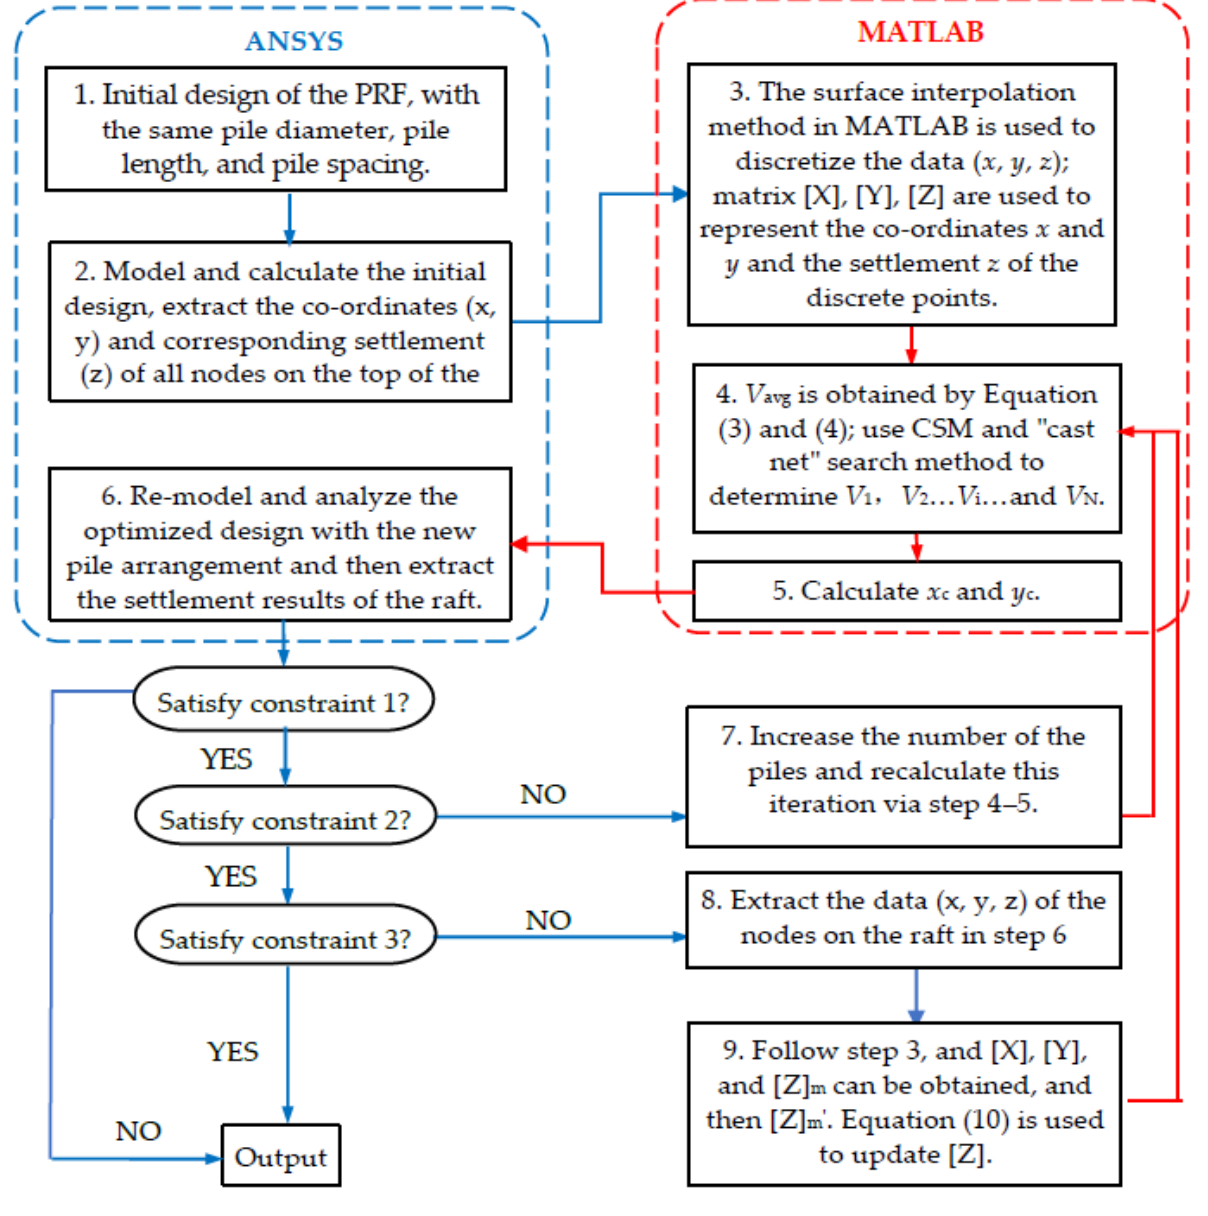
Figure 5. Flowchart of AOM.